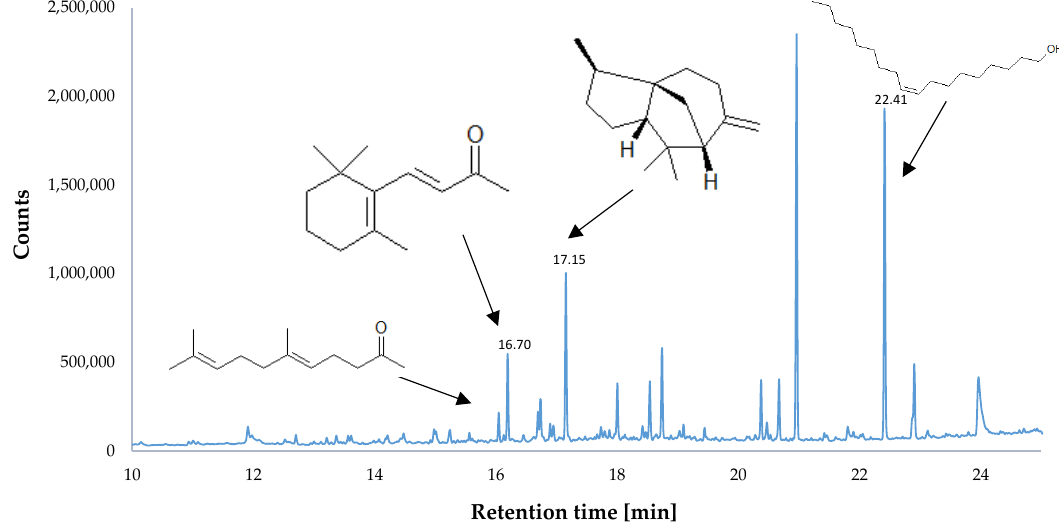
Figure 9. Chromatograms SPME-GC for the volatile fraction of rhubarb petioles (100 ppm 30 min).